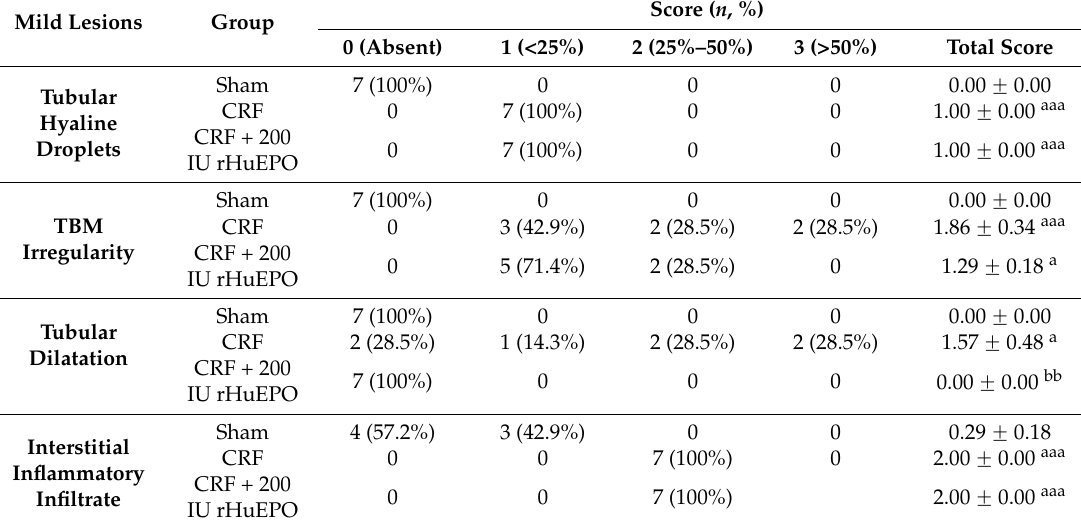
Table 3. Scoring and distribution (%) of mild and advanced tubulointerstitial kidney